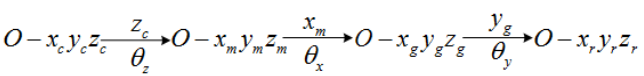
Figure 2. Relationship between the body frames and the generalized